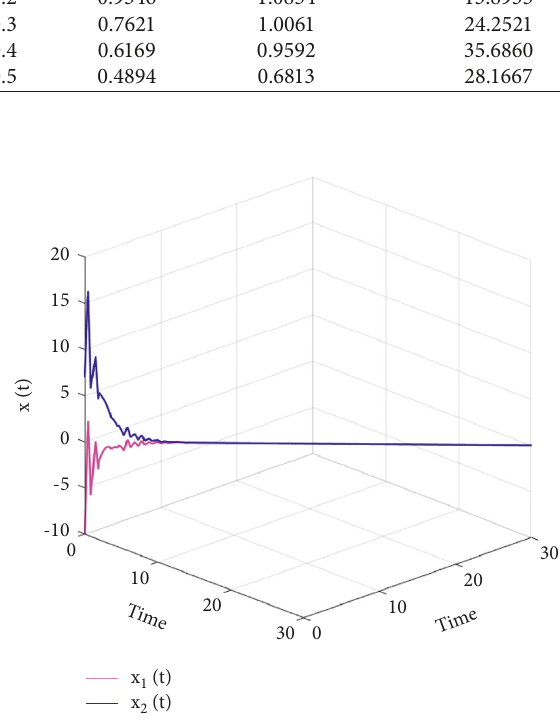
Figure 3: State responses of the original system with